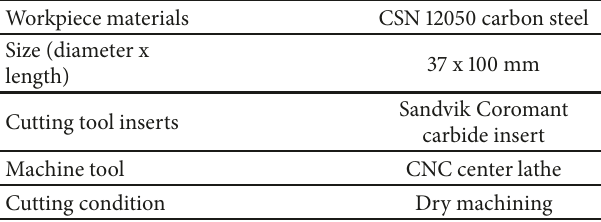
Table 4: Experimental setup and machining